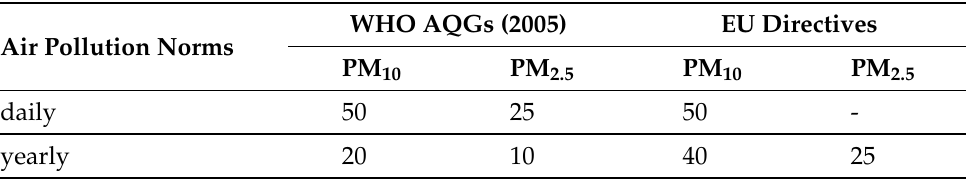
Table 1. Air quality: WHO guidelines 2005 and EU